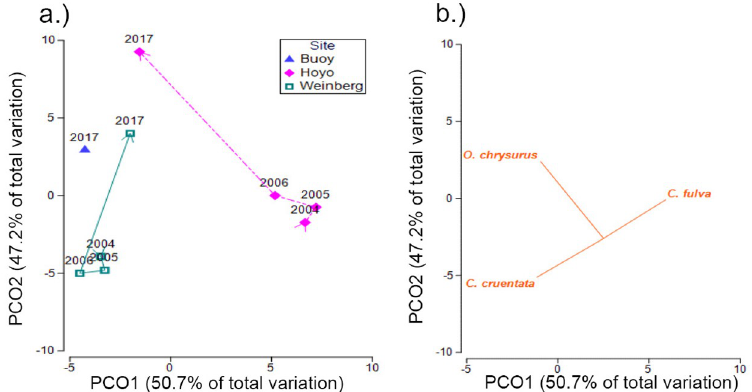
location and shape between baseline and current surveys (2005 vs. 2017) for three of four taxa (Table 9, Fig 8). Red hind was the only species assessed for which length estimates differed sig- nificantly by survey method across periods, therefore analyses of size distributions for the spe- cies were separated between roving and belt transects. Red hind FL collected in roving surveys between 2005 and 2017 increased 10–33% (mean ± SE), while those from belt transects rose 45–98% (mean ± SE). Coney was the only species assessed from the MNTZ that decreased in mean FL between 2005 and 2017, from 16.79 cm ( ± 0.33 cm) to 14.99 cm ( ± 0.26 cm).